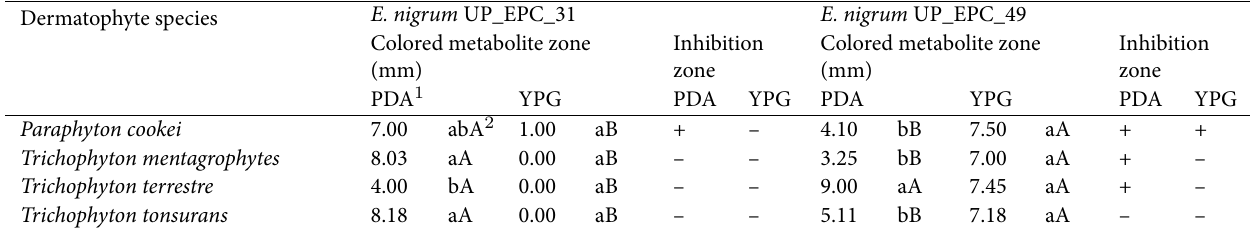
Table 3 The ability of Epicoccum nigrum isolates to synthesize colored metabolites and create inhibition zones after 10 days of combined growth with the dermatophytes. A (+) indicates the formation of an inhibition zone, and a (–) indicates the lack of such zones. The indicated values are the average of the values from four independent experiments.